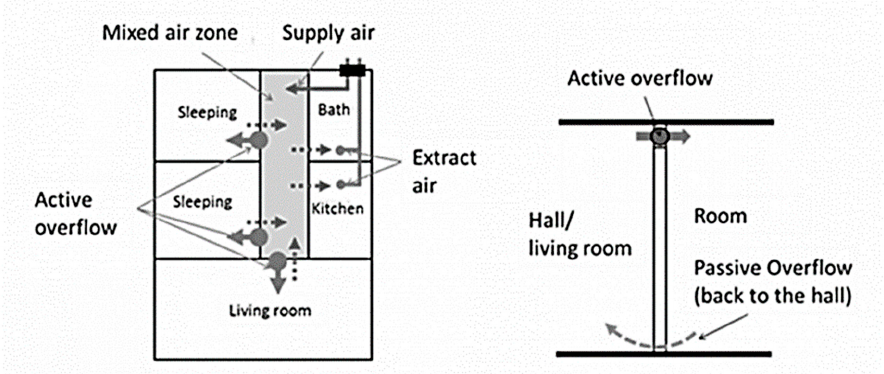
Figure 1. Passive House Ventilation concept with active overflow. Source: Passive House Institute (PHI)